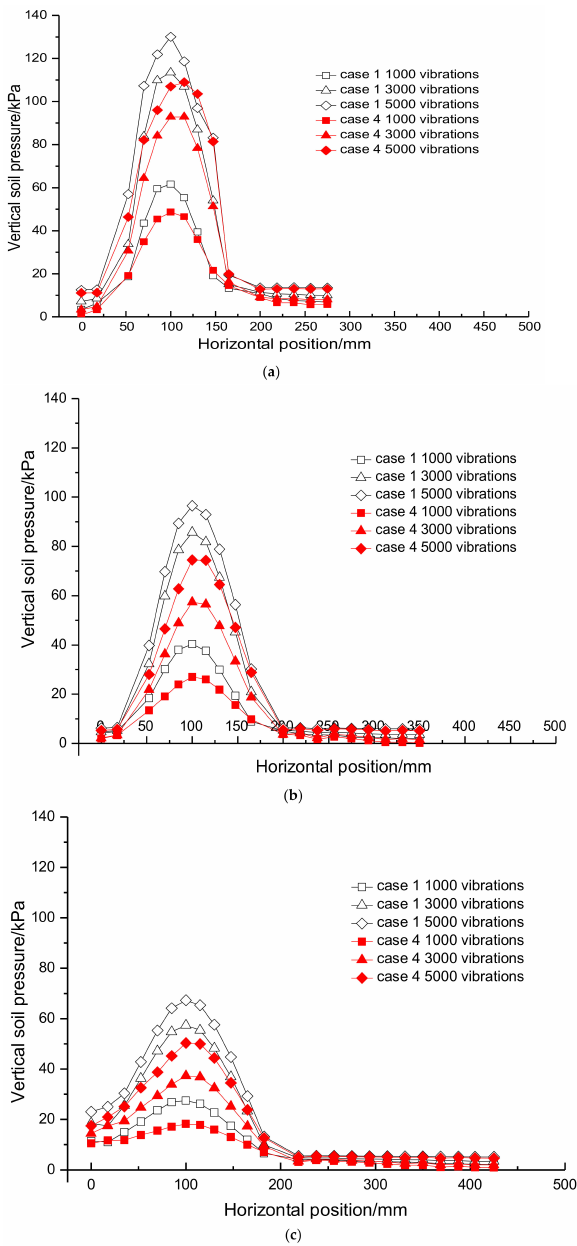
Figure 11. Vertical soil pressure in embankment under different conditions. ( a ) observation surfaces I; ( b ) observation surfaces II; ( c ) observation surfaces III. Under different loading times, the internal soil pressure of geocell reinforced em- bankment is significantly lower than that of unreinforced embankment, which reflects that the excavated geocell can still disperse the soil pressure well under cyclic